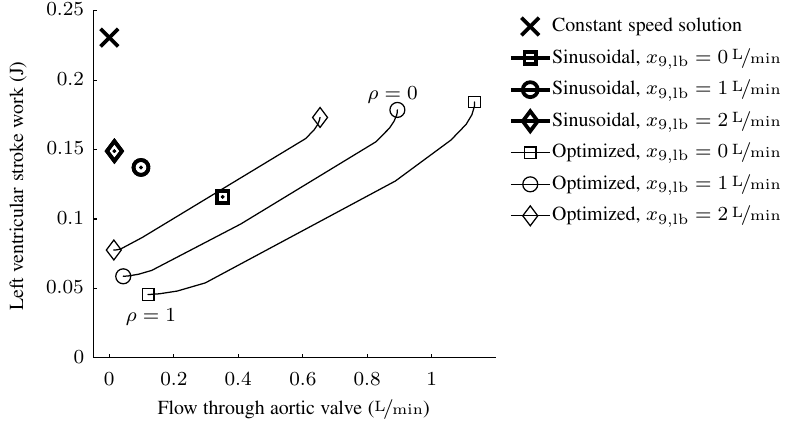
Figure 7. Tradeoff between the flow through the aortic valve and the left-ventricular stroke work. Recall that a higher flow through the aortic valve and a lower stroke work decrease the objective-function value Equation (6a). Values for the constant speed solution, the optimal sinusoidal speed profiles and the optimal solutions are shown. Three different values for the lower bound on the minimum pump flow rate are applied. The parameter, ρ , was varied between zero (the flow through the aortic valve is maximized) and one (the left ventricular stroke work is minimized). The optimal parameter set for the sinusoidal profile is invariant w.r.t. ρ ; see Figure